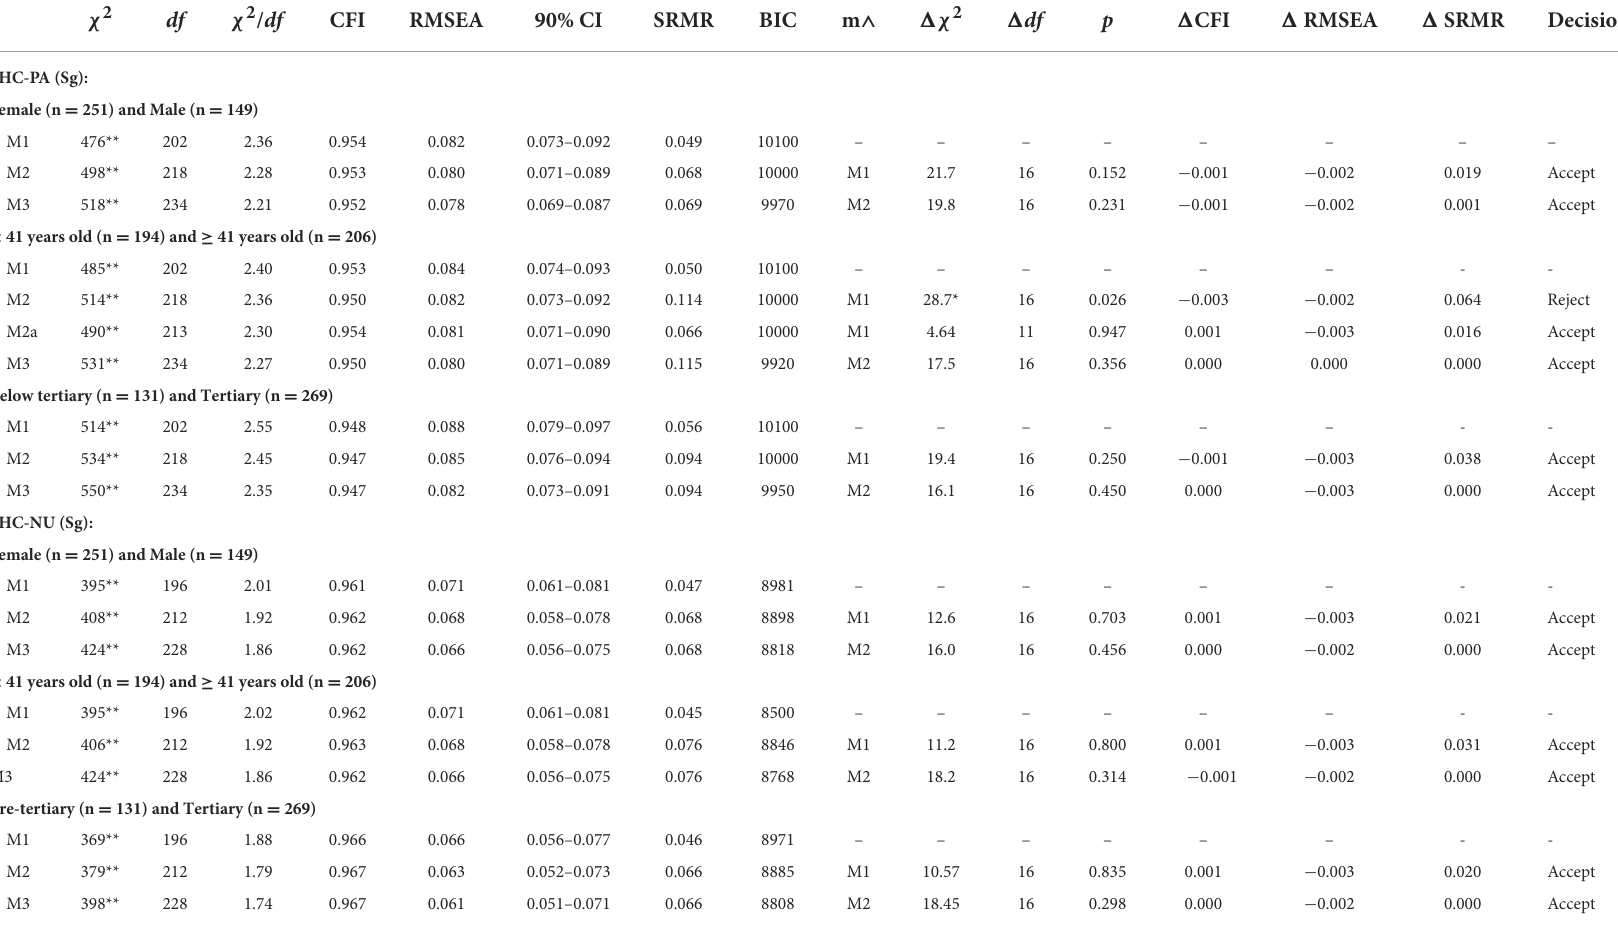
TABLE 10 Fit-indices of the models for testing of measurement